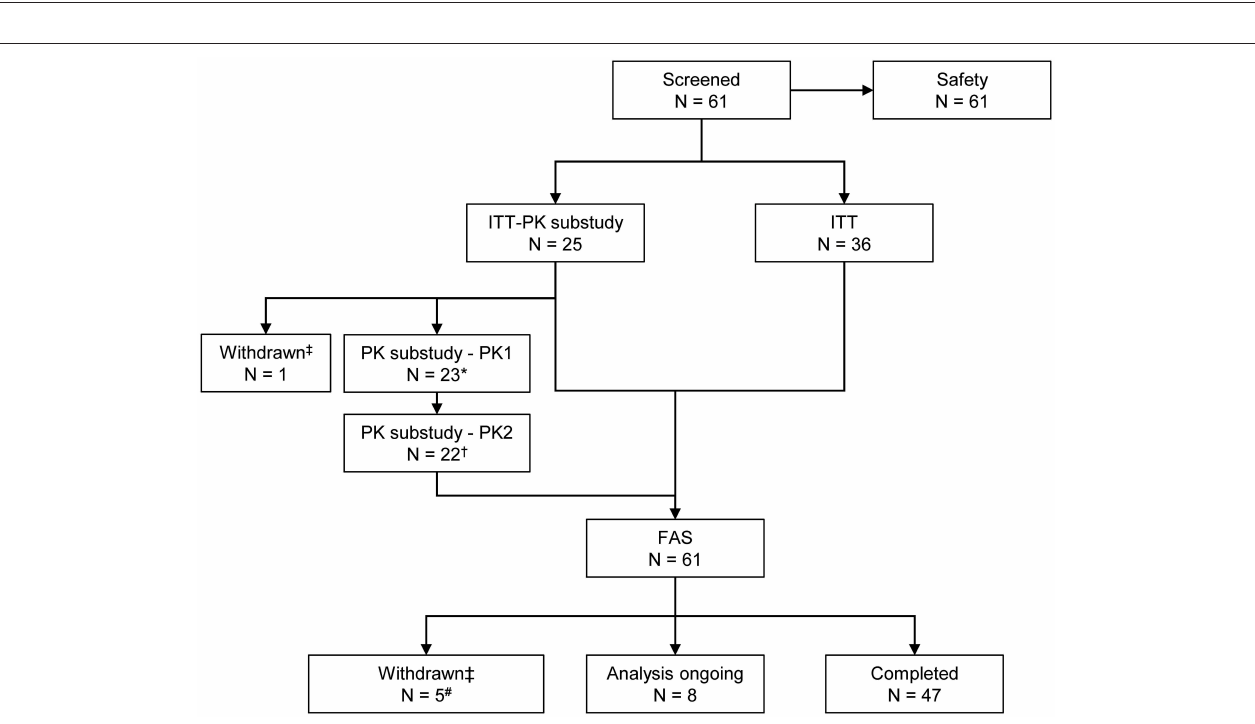
FIGURE 1 | Study design. *Study IVIG injection was only administered to the patients participating in the PK sub-study. PKIV, PK following IVIG prior to the switch to octanorm; PKSC1, PK after the 11th infusion of octanorm; PKSC2, PK after the 28th infusion of octanorm. IVIG, intravenous immunoglobulin; PK, pharmacokinetic; SCIG, subcutaneous immunoglobulin.